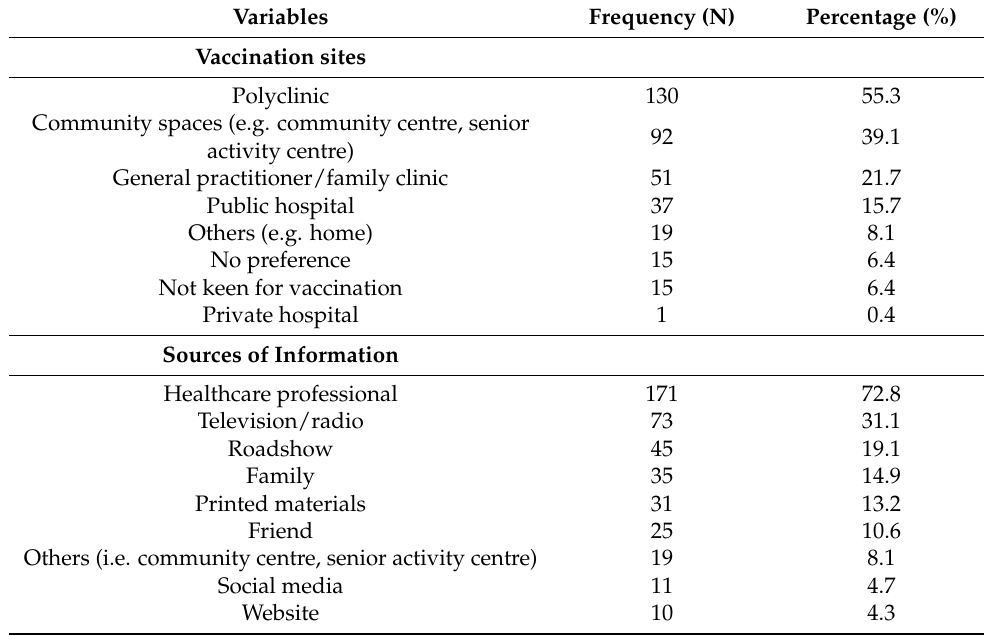
Table 6. Preferred vaccination sites and sources of information (Multiple choices allowed).